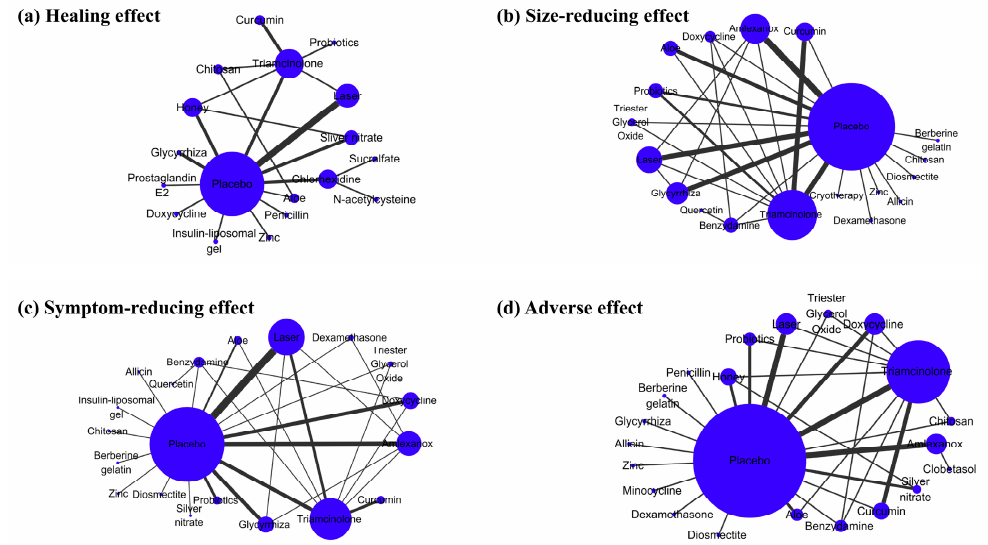
Figure 2. Network plots for the main outcomes considered in the review. ( a ) Healing effect; ( b ) size-reducing effect; ( c ) symptom-reducing effect; ( d ) adverse effect. Nodes and edges are weighted according to volume of studies, including that treatment or comparison.